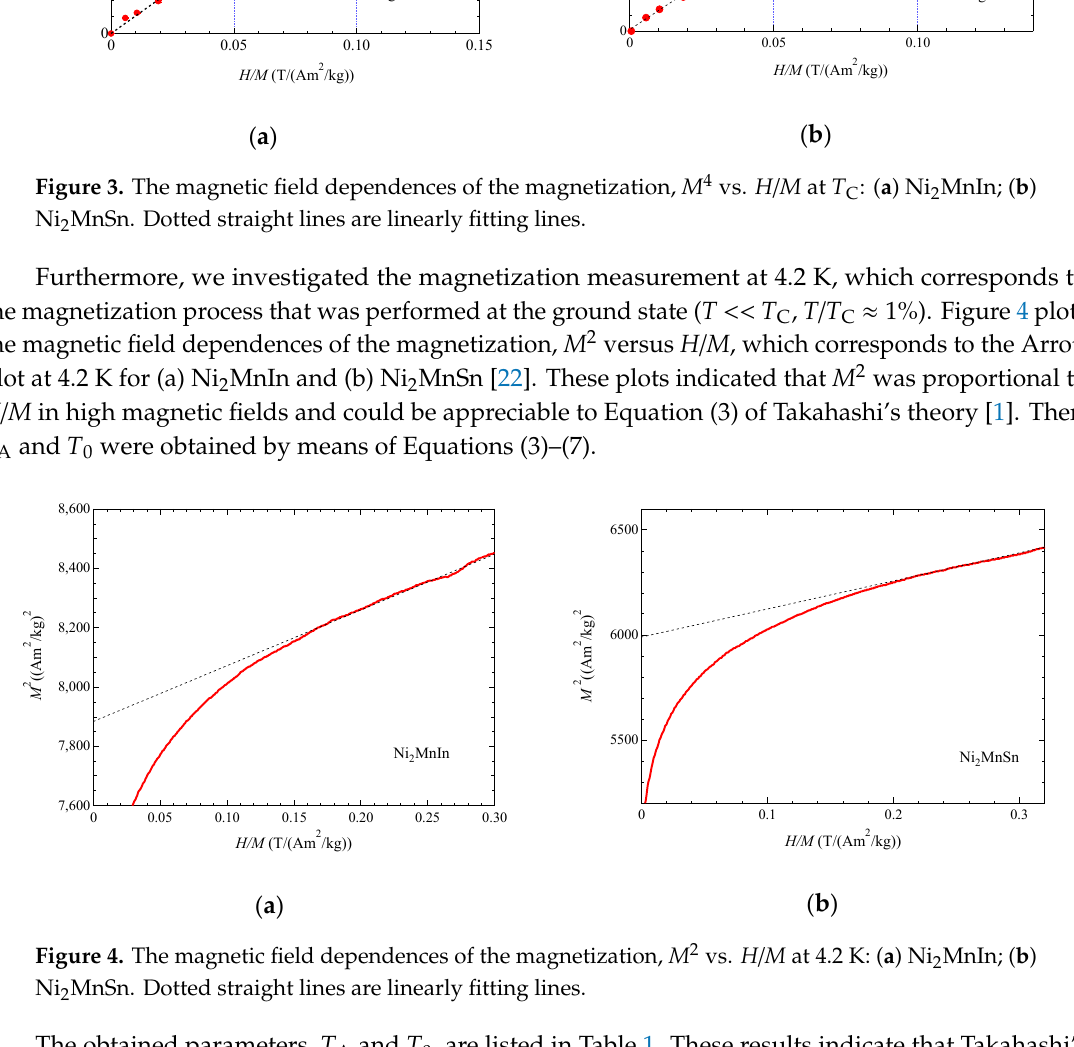
Figure 4. The magnetic field dependences of the magnetization, M 2 vs. H / M at 4.2K: ( a ) Ni 2 MnIn; ( b ) Ni 2 MnSn. Dotted straight lines are linearly fitting lines.